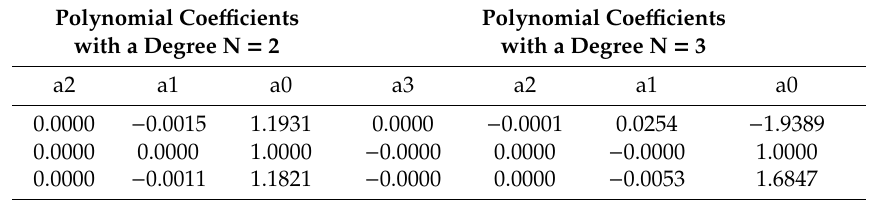
Table 2. Polynomial coe ffi cients with the degree N = 2 and N = 3 for selected correct drives (i.e., drives maintained in the designated driving track).